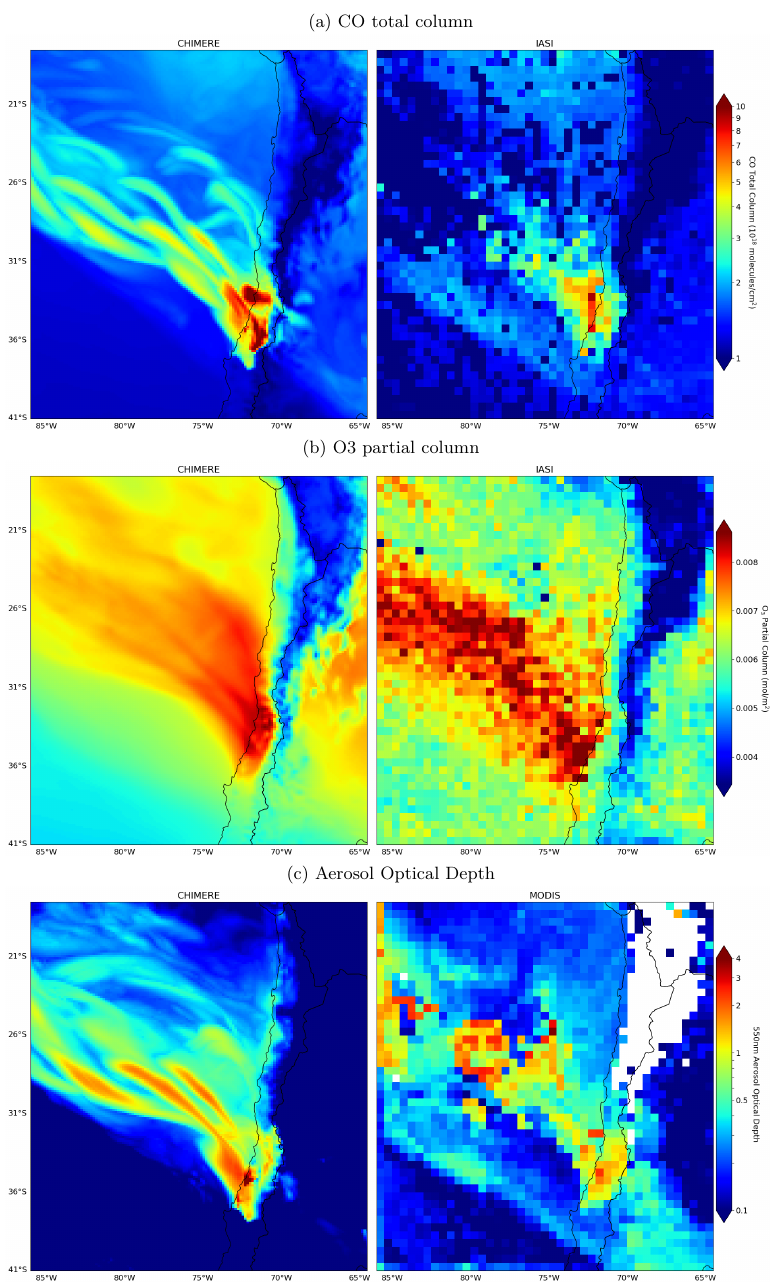
Figure 3. ( a ) CO total column composite as simulated by CHIMERE ( left ) and recorded by IASI Metop-b ( right ). ( b ) O 3 tropospheric column between 0 and 8km altitudes composite as simulated by CHIMERE ( left ) and recorded by IASI Metop-b. ( c ) 550nm Aerosol Optical Depth composite as simulated by CHIMERE ( left ) and recorded by MODIS Terra and Aqua level 2 products ( right ). All panels show composited averages for the period 25 to 29